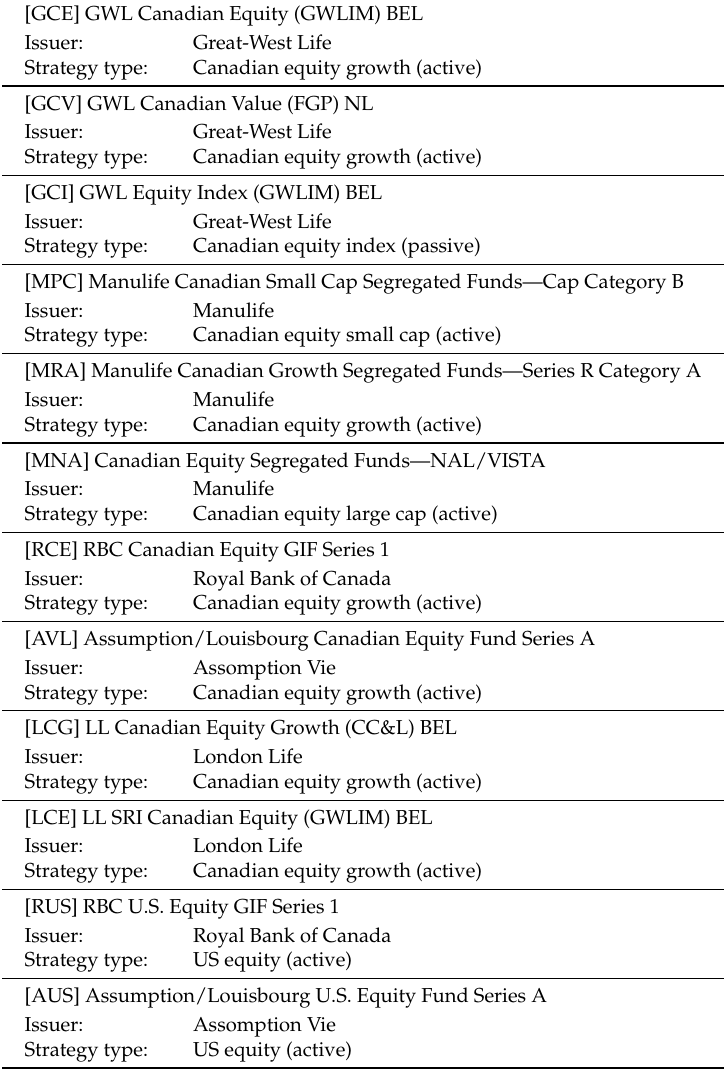
Table 1. List of funds considered for basis risk assessment. The three letters between brackets for each fund is an identifier for further